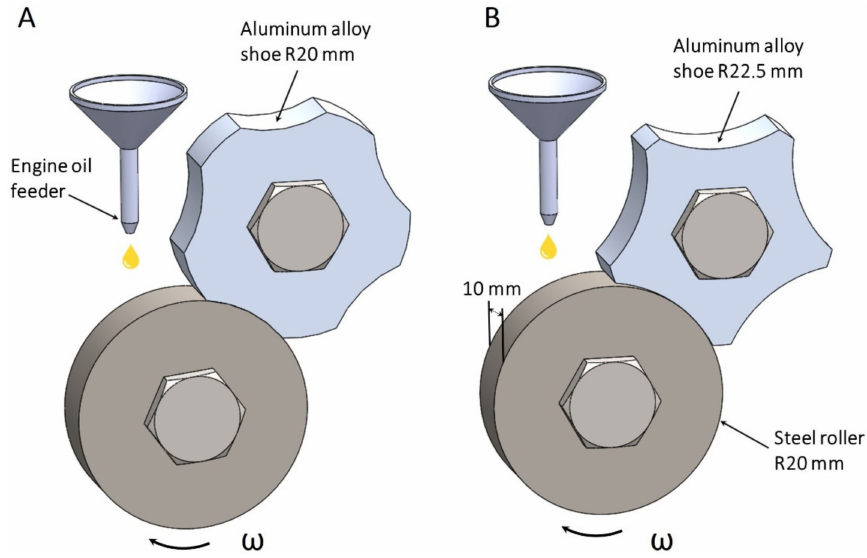
Figure 1. Experimental setup for wear and score resistance ( A ) and running-in ( B ) tests. Table 3. The chemical composition of the steel roller. Elements Composition,